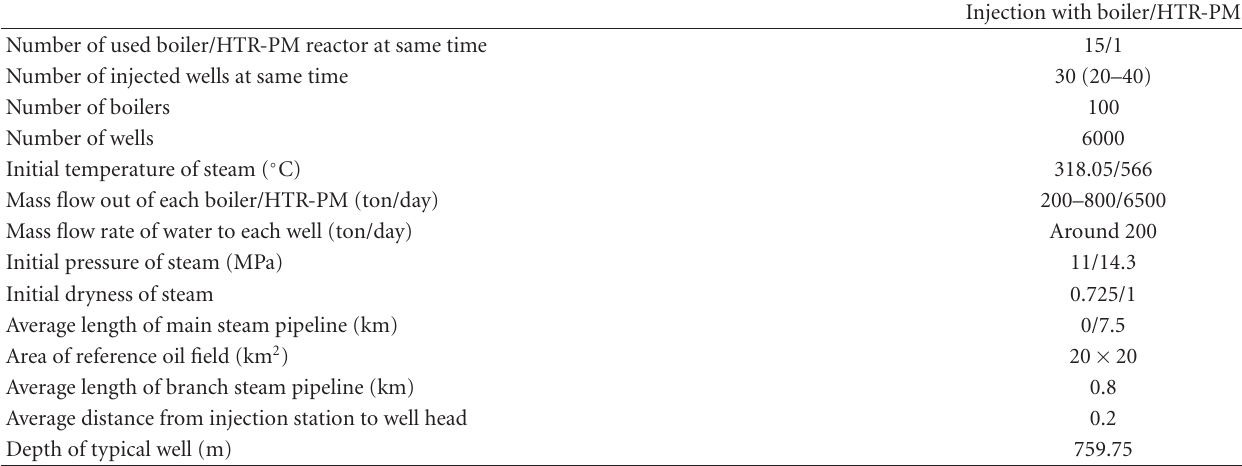
Table 2: Basic configuration of injection.